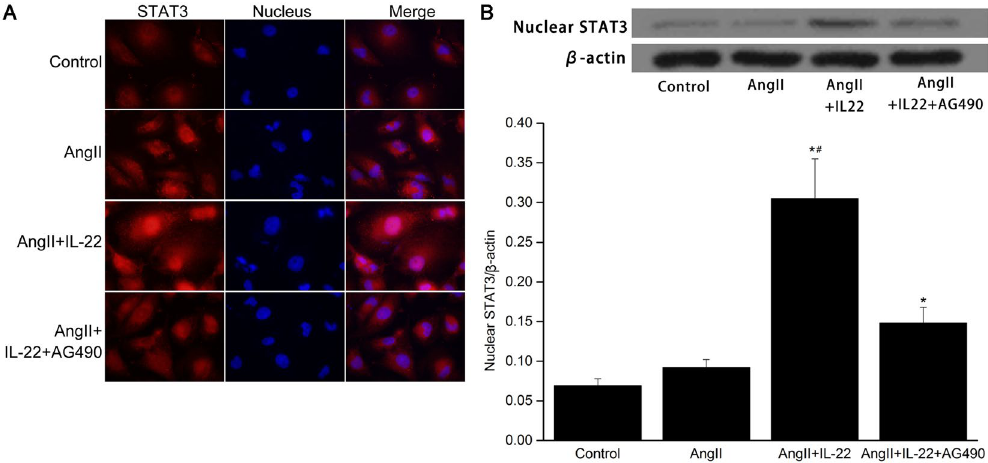
Figure 7. IL-22 significantly stimulated nuclear STAT3 expression in PMVECs. ( A ) STAT3 was mainly localized in the cytoplasm in the control group and AngII group. The expression of STAT3 in the nucleus in the AngII + IL22 group significantly increased, while its expression in the nucleus significantly decreased in the AngII + IL22 + AG490 group. ( B ) Western blot analysis indicated the STAT3 in the nucleus in the AngII + IL22 group was significantly higher than the other groups. The raw data were listed in the Supplementary file. * P < 0.05 versus control group; # P < 0.05 versus AngII + IL-22 + AG490